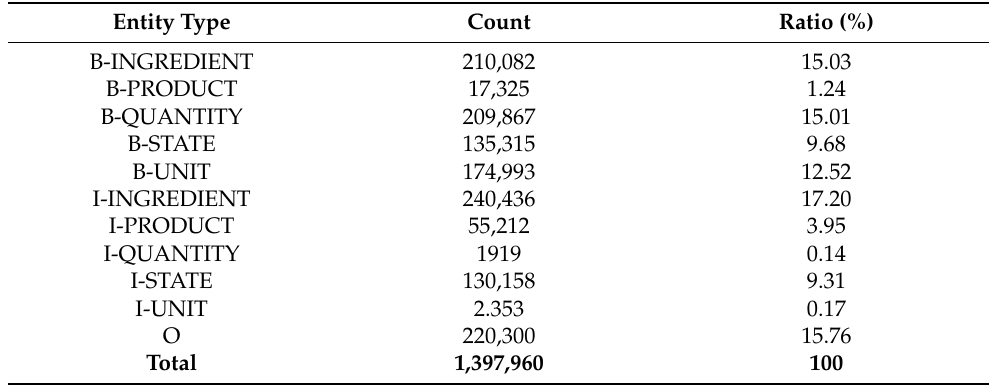
Table 6. The dataset distribution for named